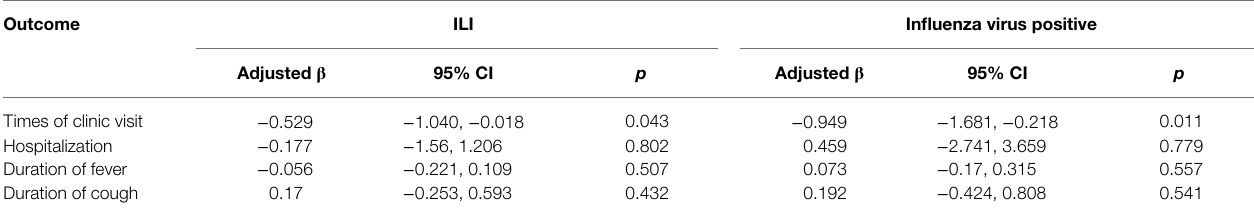
TABLE 4 | Outcomes of the ILI and influenza virus-positive patients with or without oseltamivir